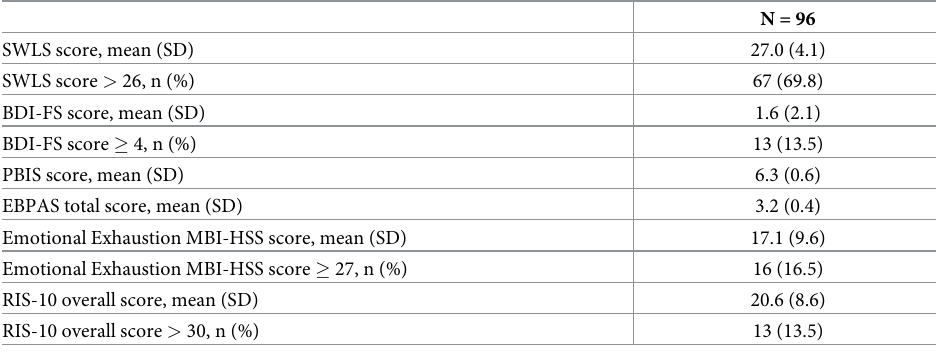
Table 2. Behavioral characteristics of the sample.